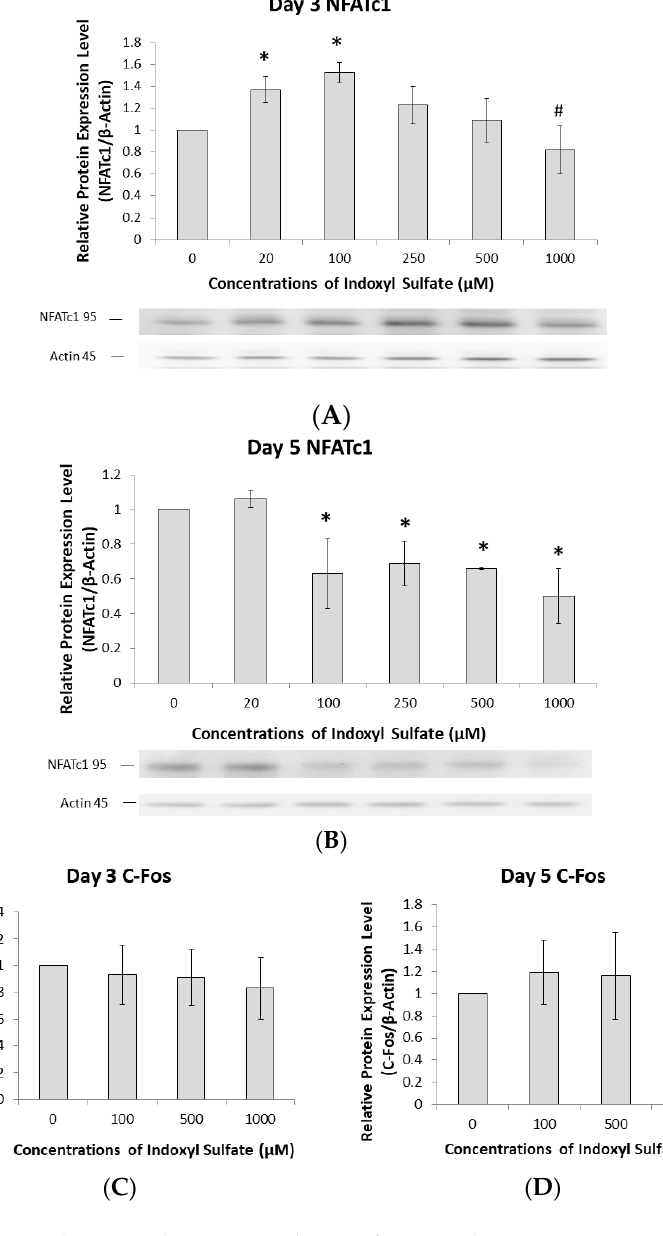
Figure 3. The AhR pathway mediates IS regulation of NFATc1 but not c-Fos. Raw 264.7 cells with 50 ng/mL of sRANKL were cultured in IS at 0, 100, 500, and 1000 µM for 3 and 5 days. ( A ) NFATc1 expression in osteoclast precursors on Day 3 depends on the IS concentration. Western blot analysis showed that < 100 µ M IS increased NFATc1 expression, but > 250 µ M inhibited it in a dose-dependent manner. Error bars represent mean ± SD ( n = 3). * p < 0.05 compared to the control group. # p < 0.05 compared to 100 µ M IS. ( B ) NFATc1 expression in mature osteoclasts on Day 5 depends on the IS concentration. Western blot analysis showed that 20 µ M IS increased NFATc1 expression, but > 100 µ M decreased it. Error bars represent mean ± SD ( n = 3). * p < 0.05 compared to the control group. ( C , D ) c-Fos expression in osteoclasts at di ff erent IS concentrations on Day 3 and 5. Western blot analysis showed no significant relationship between c-Fos expression and IS concentrations. Error bars represent mean ± SD ( n = 4).